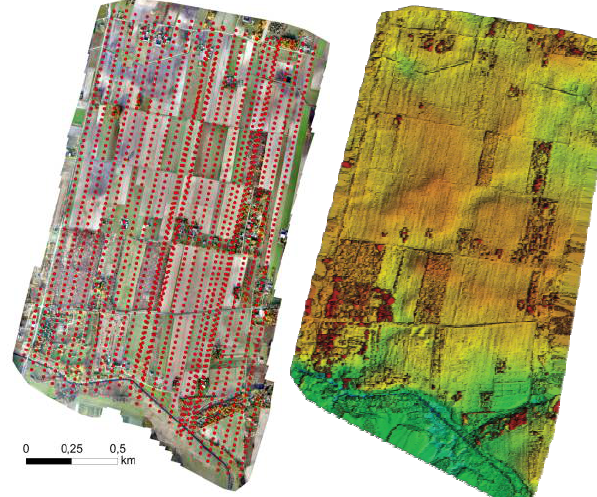
Figure 1. The test area of the Podkampinos cadastral district, the Kampinos Municipality, Mazovia Voivodship, the resulting orthophotomap with marked image centres and the digital surface model (DSM)